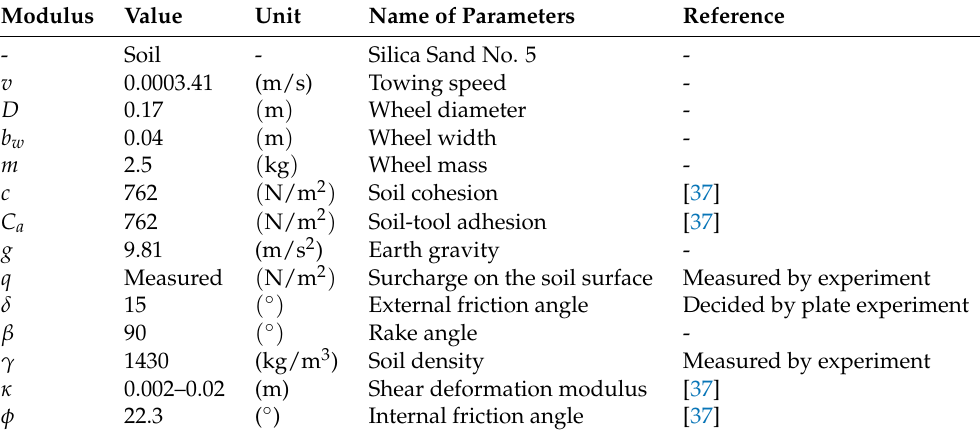
Table 6. Soil parameters and values for calculation of resistance force.